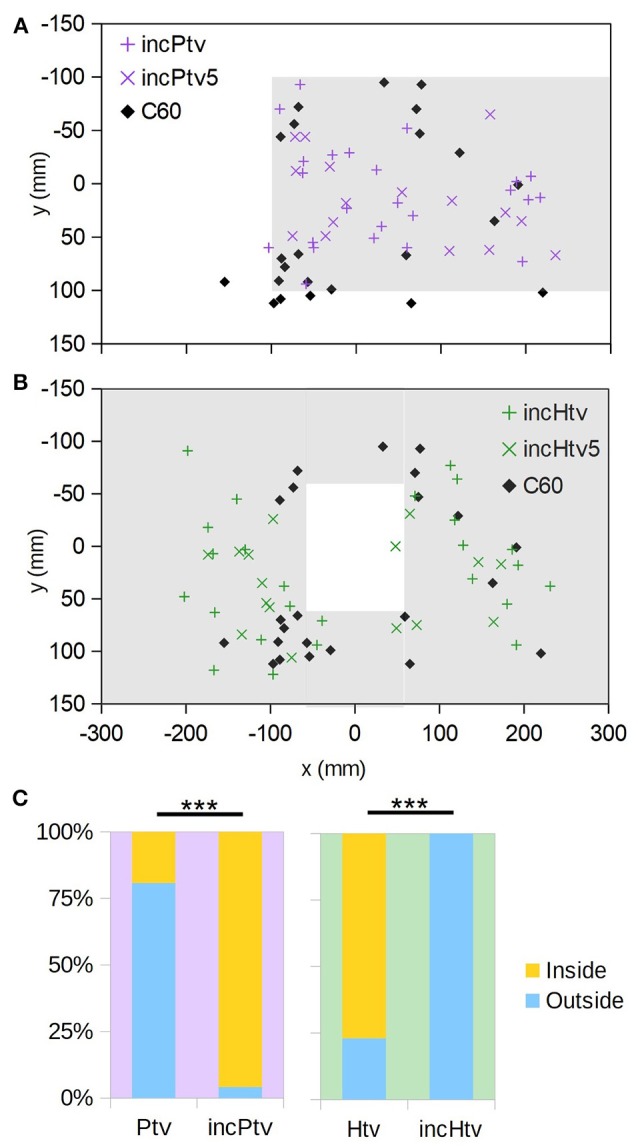
Incongruent virtual objects. (A) (x,y) positions at which individuals initially descended through the plane of the virtual “background” (i.e., z = 60 mm); the extent of the platform (z = 0 mm, but occluding the background) is indicated by gray shading. Coloured “+” symbols are for the case where the background chequerboard is composed of squares of the usual size (10 mm), “×” symbols for the case where they are 5 mm, and black diamonds are the control condition where no obstacle exists (C60). (B) As A, but for the incongruent hole obstacle. (C) Comparison with the congruent conditions (Figure 4) showing how frequently animals descended through the z = 60 mm plane inside vs. outside of the platform/hole. “***” denotes p < 0.001 (Fisher's exact test); numbers of individuals are as follows: nPtv = 26, nincPtv = 24, nHtv = 26, nincHtv = 25.